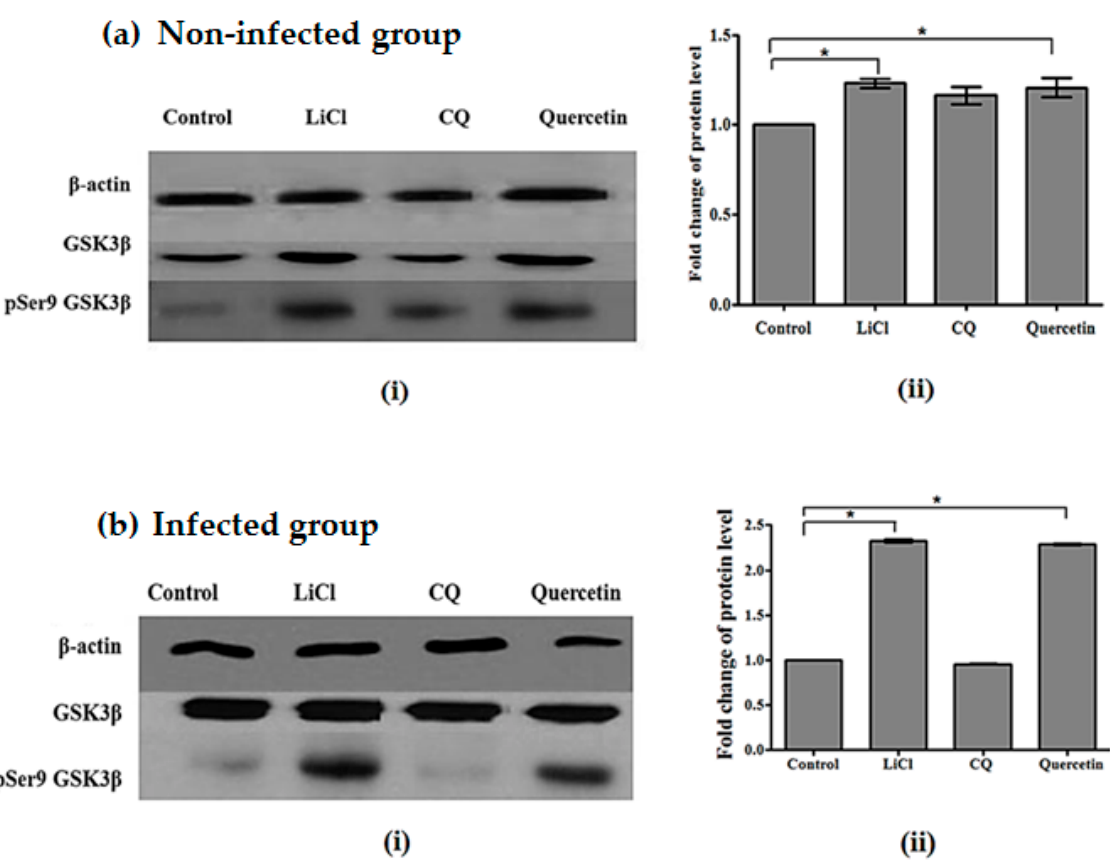
Figure 3. ( a ) (i) Intensity of immunoreactive bands for pSer9 GSK3 β and GSK3 β (ii) Fold change of phosphorylated protein levels in the brain of non-infected mice; ( b ) (i) Intensity of immunoreactive band for pSer9 GSK3 β and GSK3 β (ii) Fold change of phosphorylated protein levels in mice infected with P. berghei ANKA treated with LiCl, CQ, or quercetin for four days. Total GSK3 β protein expression levels were normalised to β -actin, and pGSK3 β was normalised to total GSK3 β protein level. Densitometric measurements are illustrated as mean (fold) ± SD of corresponding measurements in non-treated controls. Significant differences between control and test groups were measured at p < 0.05 (*).